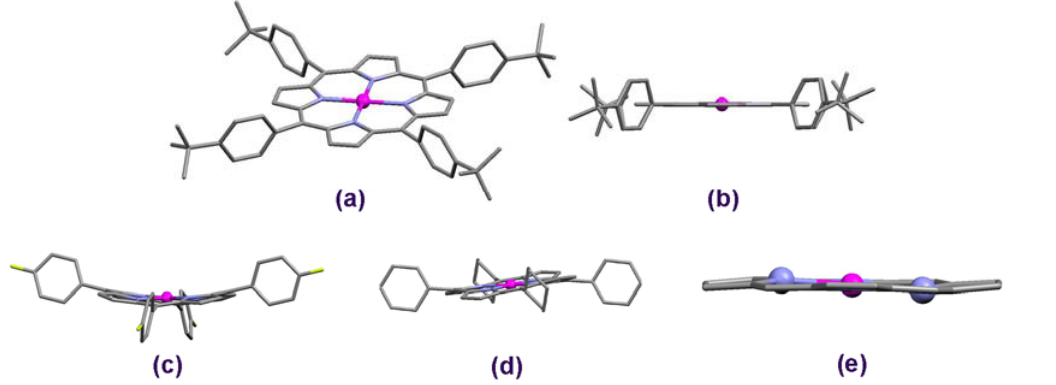
Figure 2. Molecular structure of diverse Zn-pophyrins (derived from crystallographic data). Structures ( a ) and ( b ) refer to ZnTBPP [7]; ( c ) Cyanophenyl analogue (R = 1, X = CN) [9]; ( d ) Cyclohexyl analogue (R = 2) [10]; ( e ) Bent pyrrole units of the porphyrin core, adapted from [11]; two opposite nitrogen atoms have been highlighted as blue balls to emphasize the